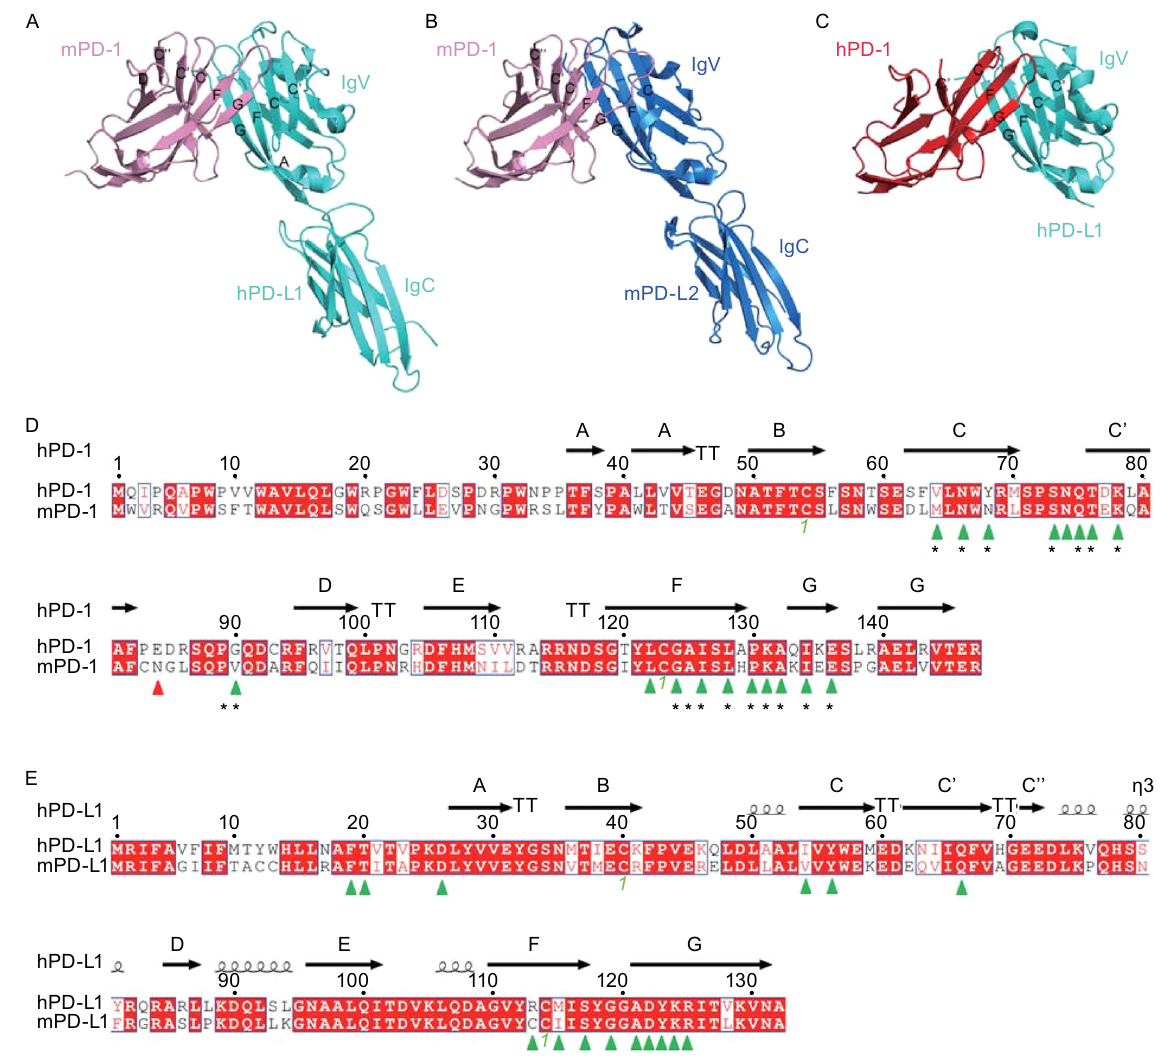
Figure 1. Overall structure of the mPD-1/hPD-L1, mPD-1/mPD-L2, and hPD-1/hPD-L1 complexes. Cartoon structures of mPD-1/ hPD-L1, mPD-1/mPD-L2, and hPD-1/hPD-L1 complexes. The strands that contribute to interaction are labeled as indicated. A. pink, mPD-1; cyan, hPD-L1. B. pink, mPD-1; sky blue, mPD-L2. C. red, hPD-1; cyan, hPD-L1. D. Sequence alignment of the extracellular IgV domains of hPD-1 and mPD-1. Green triangle labels show the amino acids that interact with both hPD-L1 and mPD-L1 from the complex structures of mPD-1/hPD-L1 and hPD-1/hPD-L1 (PDB: 3BIK, 4ZQK). The red triangle label indicates the amino acids that contribute to the interaction within hPD-1 but not mPD-1. Black asterisks indicate the amino acids within mPD-1 that interact with mPD-L2. E. Sequence alignment of the extracellular IgV domains of hPD-L1 and mPD-L1. Green triangle labels show the amino acids that interact with both hPD-L1 and mPD-L1 from the complex structures of mPD-1/hPD-L1 and hPD-1/hPD-L1 (PDB: 3BIK, 4ZQK). The green number in both D and E indicates the two Cys residues that form an intra-domain disul fi de